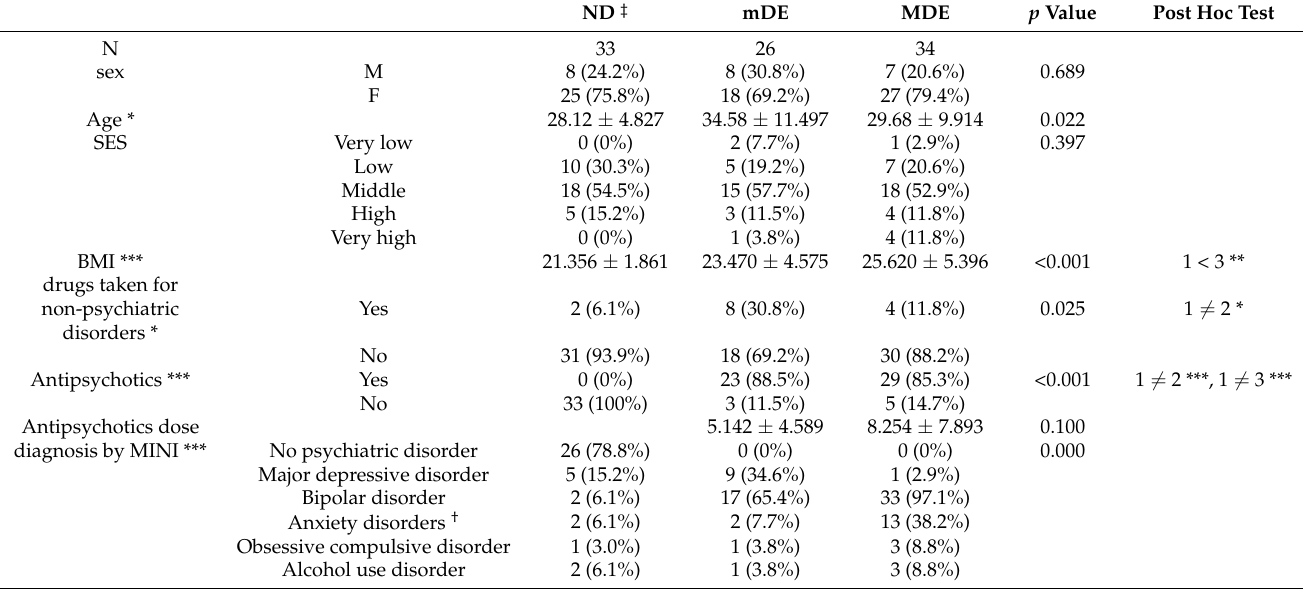
Table 1. Comparison of demographics according to depressive episodes.